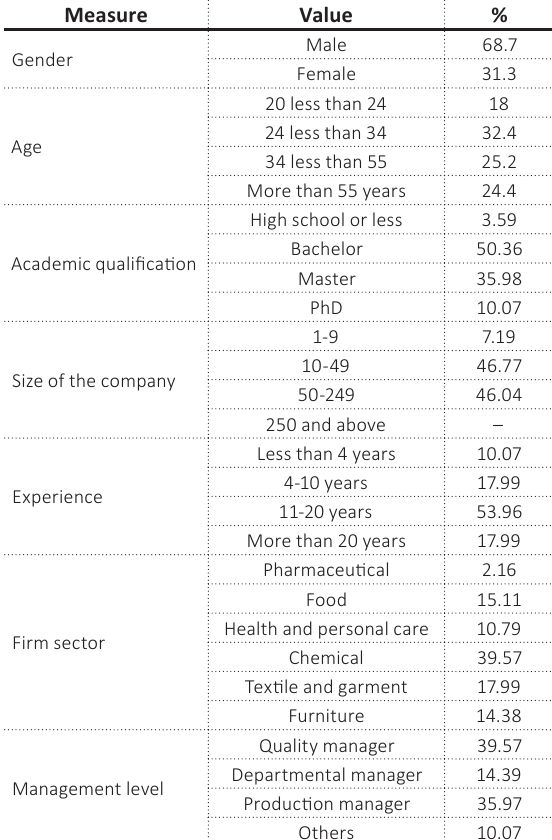
Table 1. Sample characteristics